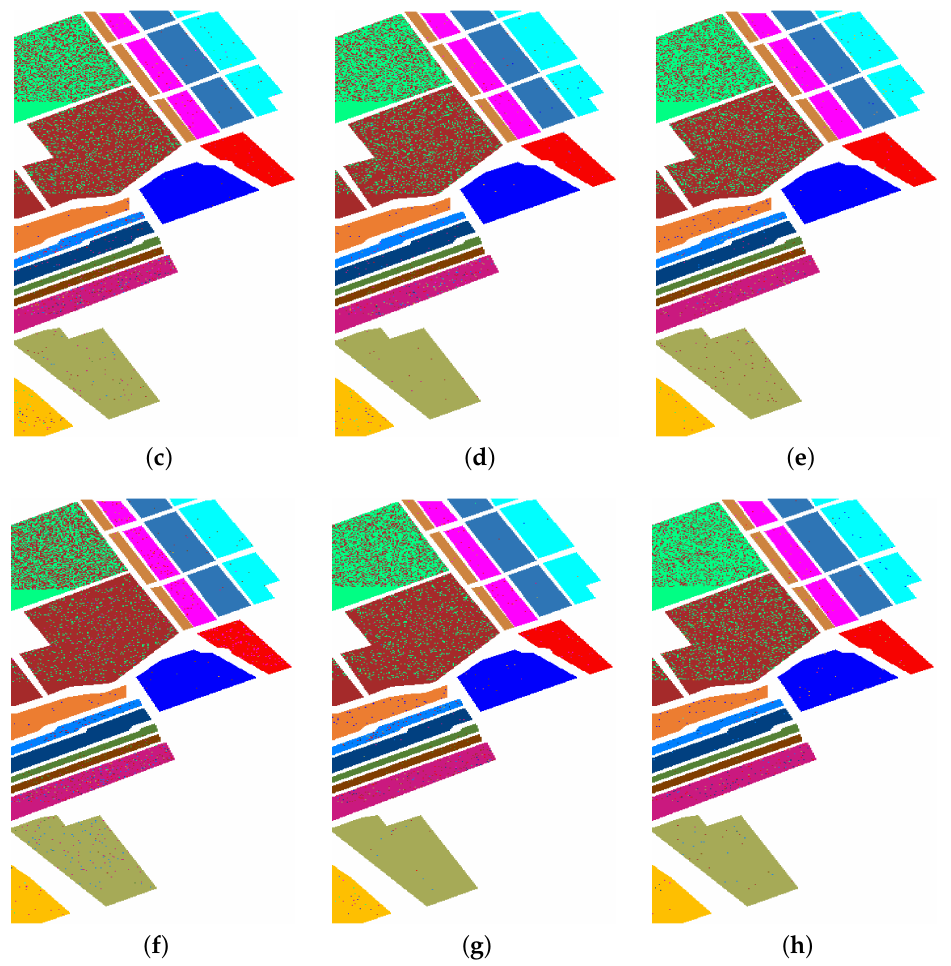
Figure 5. Ground truth (GT) and classification maps of SVM, RF, RoF, CNN, SMOTE-RoF, RBDF as well as the proposed SMOTE-WDRoF method on the hyperspectral data Salinas . ( a ) GT. ( b ) SVM. ( c ) RF. ( d ) RoF. ( e ) SMOTE-RoF. ( f ) CNN. ( g ) RBDF. ( h )